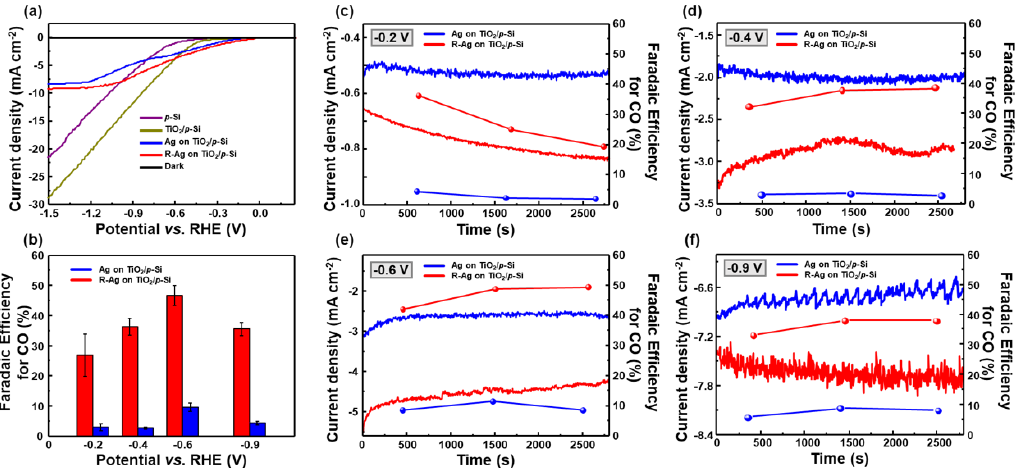
Figure 3. Performances of photoelectrochemical CO 2 reduction of Ag and R-Ag catalysts on SiO 2 patterned TiO 2 / p -Si photocathodes under 1 sun illumination (AM 1.5 G) in CO 2 -saturated 0.1 M KHCO 3 electrolytes. ( a ) Polarization curves and ( b ) Faradaic e ffi ciency of the fabricated photocathodes. The current density (— left axis) and faradaic e ffi ciency for CO ( • right axis) vs. time on the Ag catalysts (blue) and the R-Ag catalysts (red) on SiO 2 patterned TiO 2 / p -Si photocathodes at ( c ) − 0.2 V, ( d ) − 0.4 V, ( e ) − 0.6 V, and ( f ) − 0.9 V.